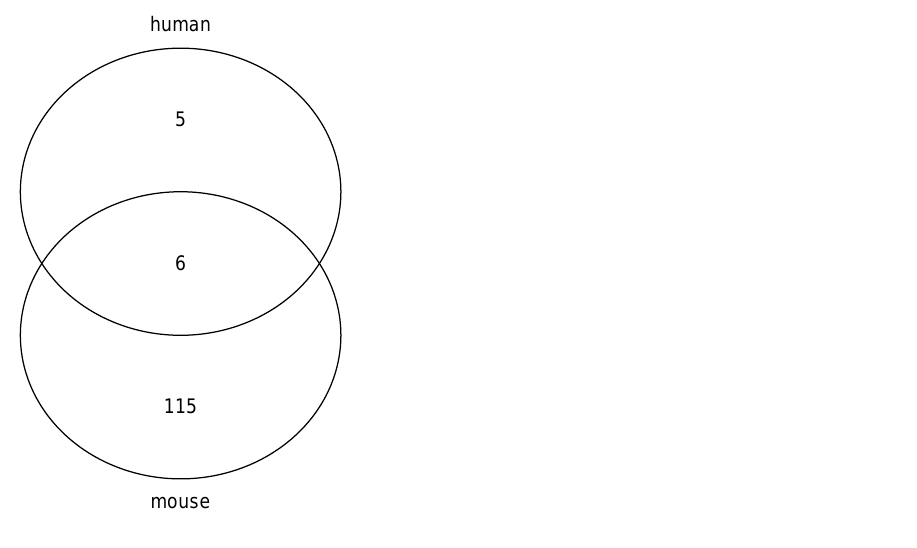
Figure 8. Venn diagram of REACTOME pathways in "Reactome 2016" category, selected by uploading genes selected by TD-based unsupervised FE to Enrichr. Table 8. Six commonly selected KEGG pathways from Figure 8.